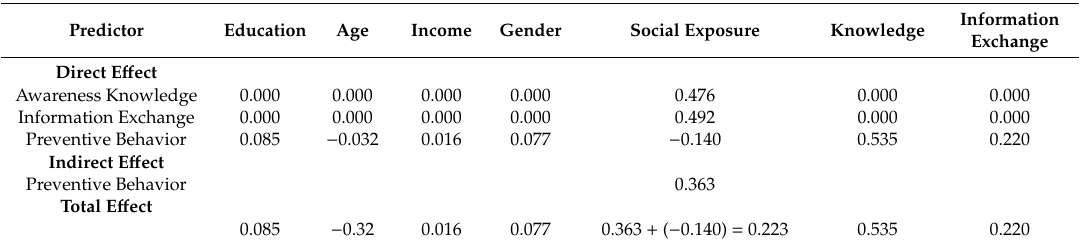
Table 5. Direct / indirect and total e ff ects (group number 1—default model).